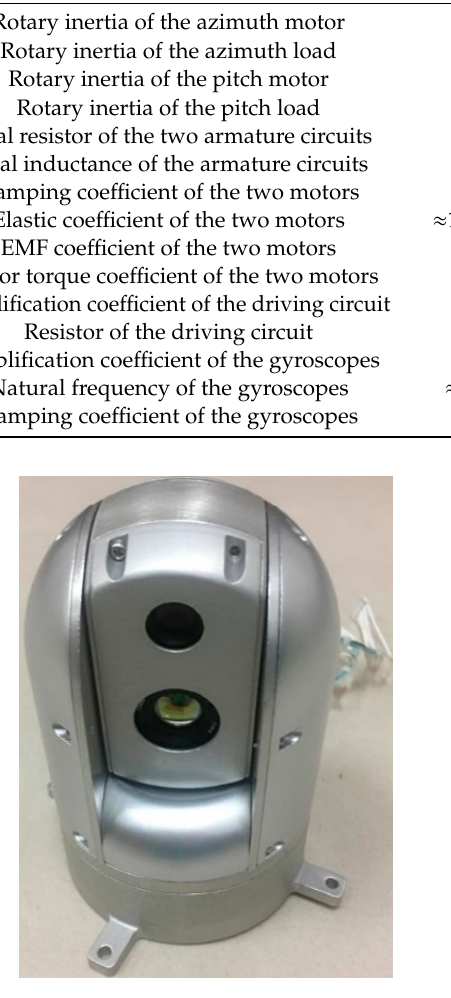
Figure 15. The assembly prototype of the newly developing system.